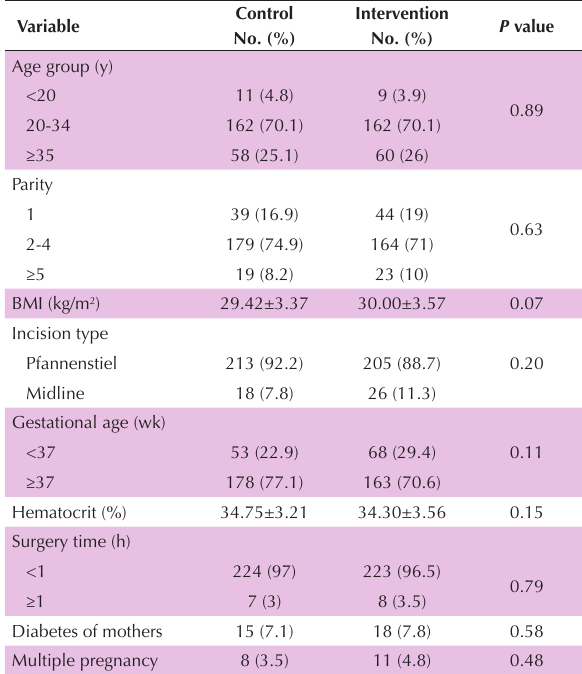
Table 1. Distribution of frequency of demographic and clinical characteristics of mothers undergoing cesarean section by group Variable